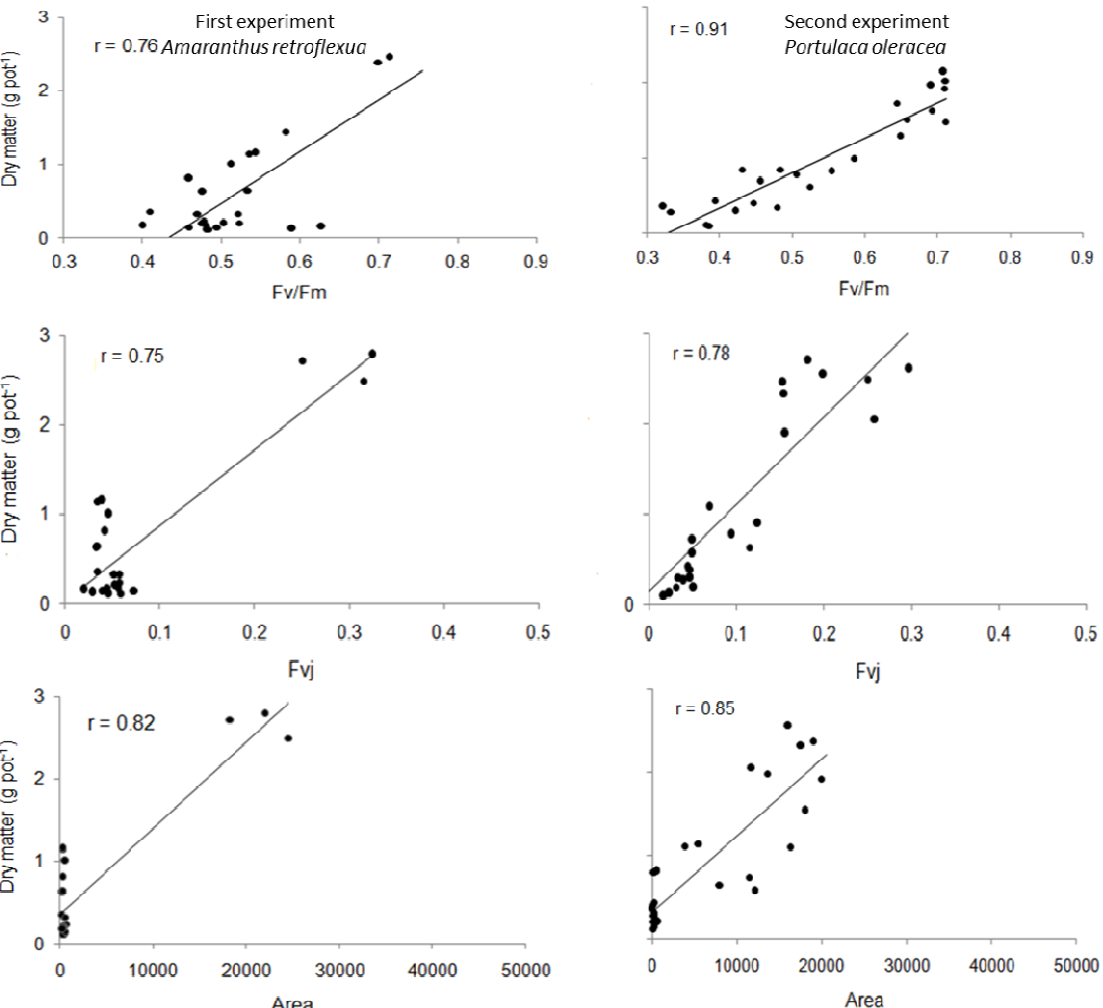
Fig. 5. The relationship between dry matter and chlorophyll fluorescence parameters (F [HAS] in two experiments. (Left, Amaranthus retroflexus sprayed by desmedipham + phenmedipham + ethofumesate in the first experiment; right, Portulaca oleracea sprayed by chloridazon in the second